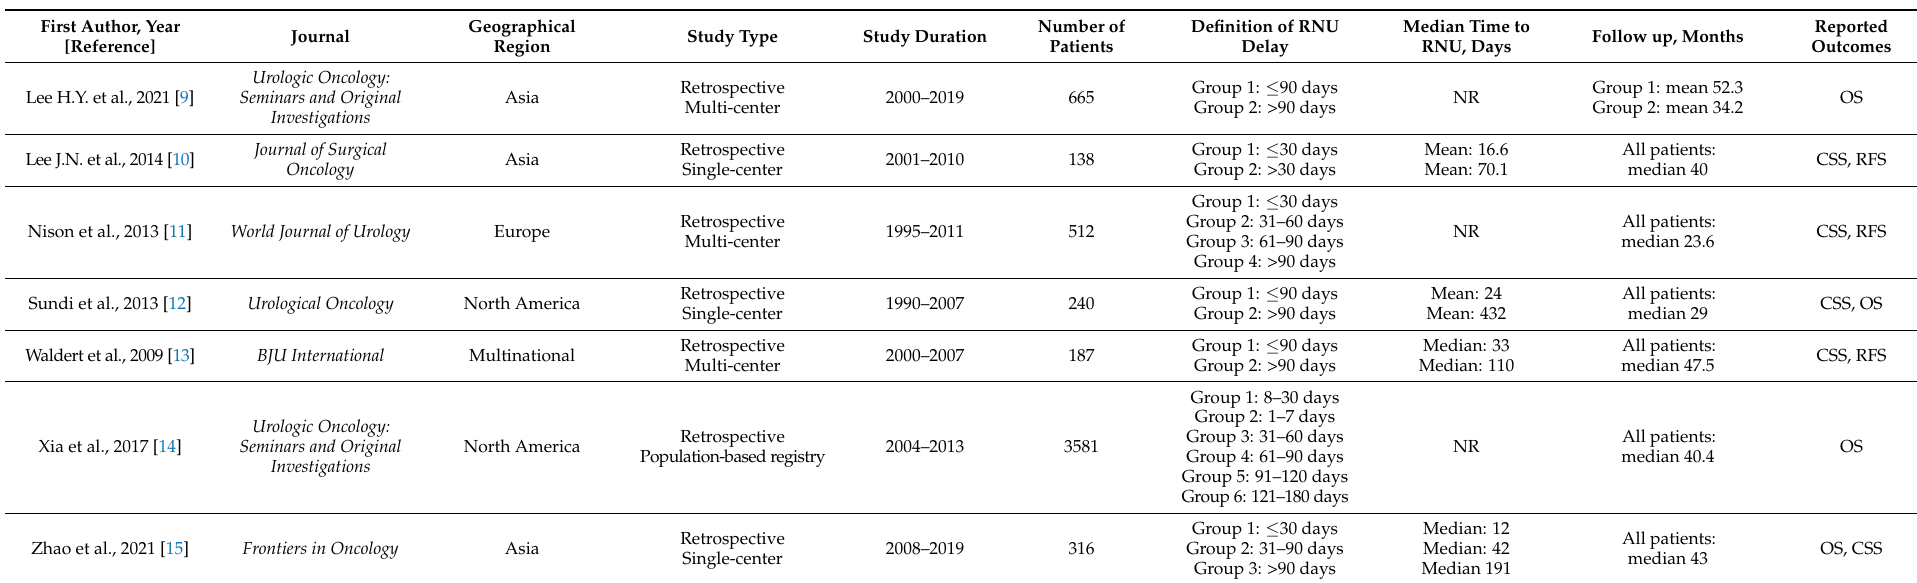
Table 1. Baseline characteristics of included